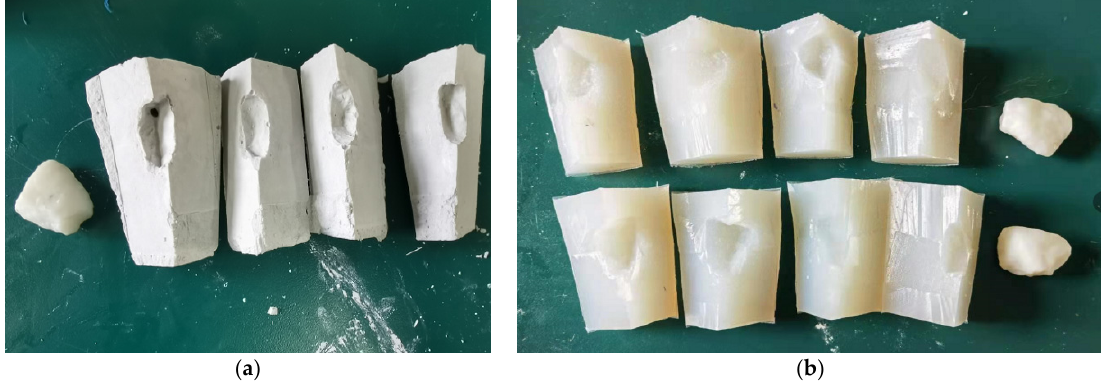
Figure 11. The prepared two molds ( a ): plaster mold; ( b ): silica mold. Grouting Process